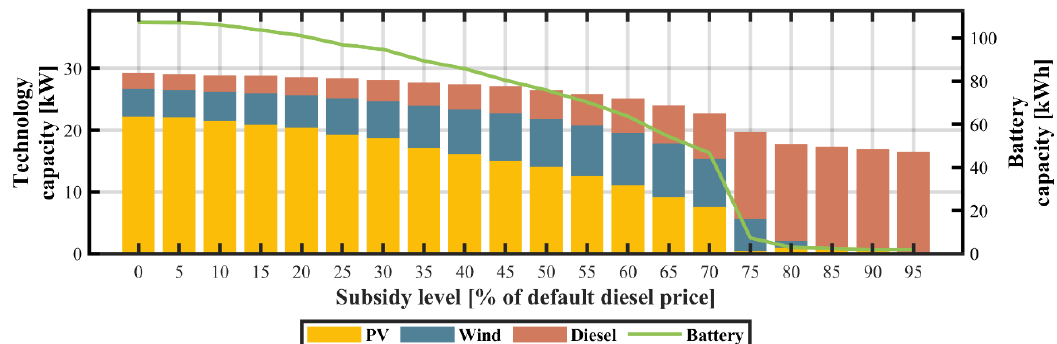
Figure 17. Simulation results of diesel fuel subsidies. Impact on the capacity of DG technologies.